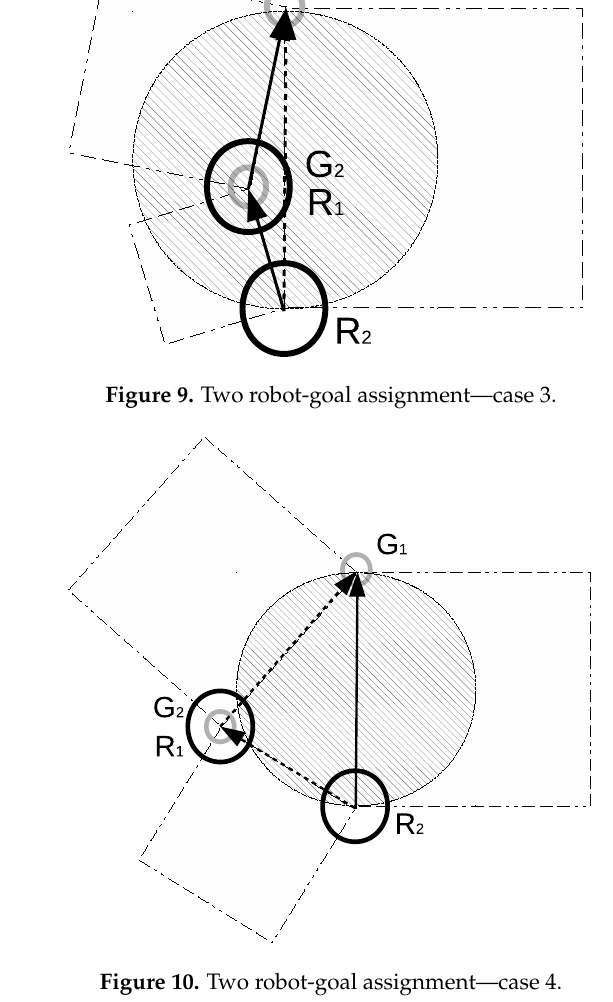
Figure 10. Two robot-goal assignment—case